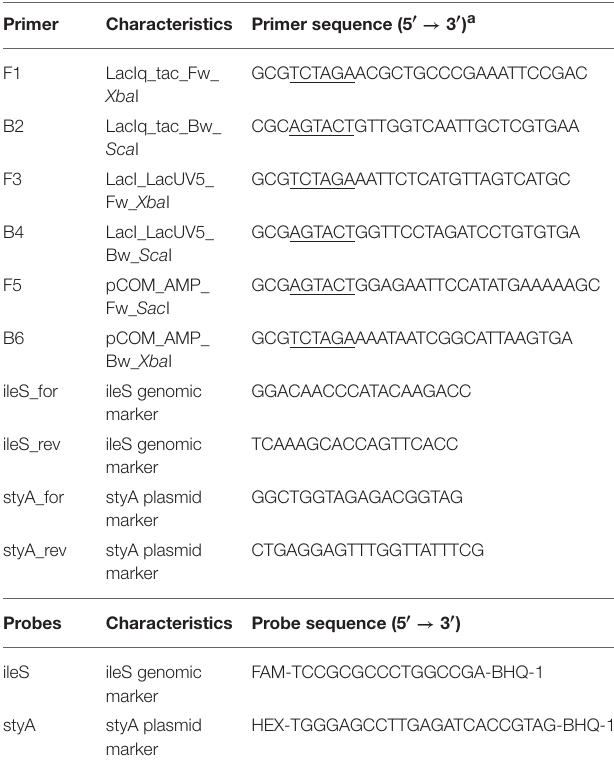
TABLE 2 | Oligonucleotide primers and probes used in this study.